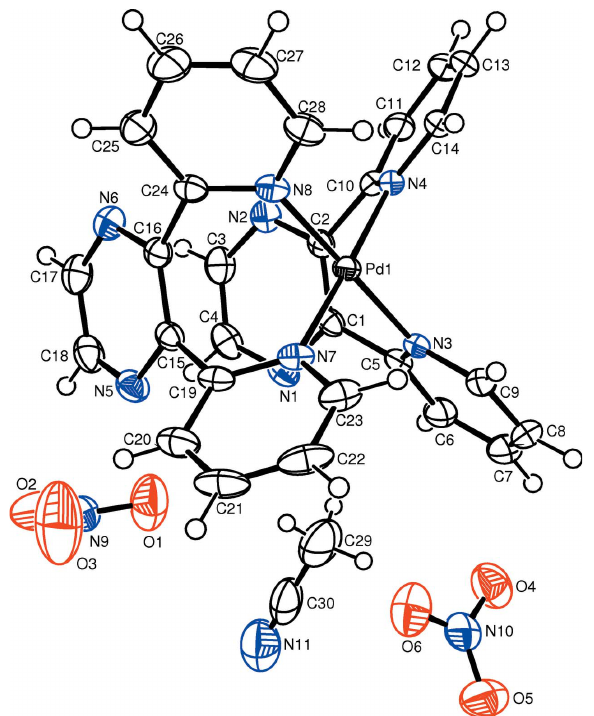
Figure 1 The molecular structure of the title compound showing the atom labelling and displacement ellipsoids drawn at the 50% probability level for non-H